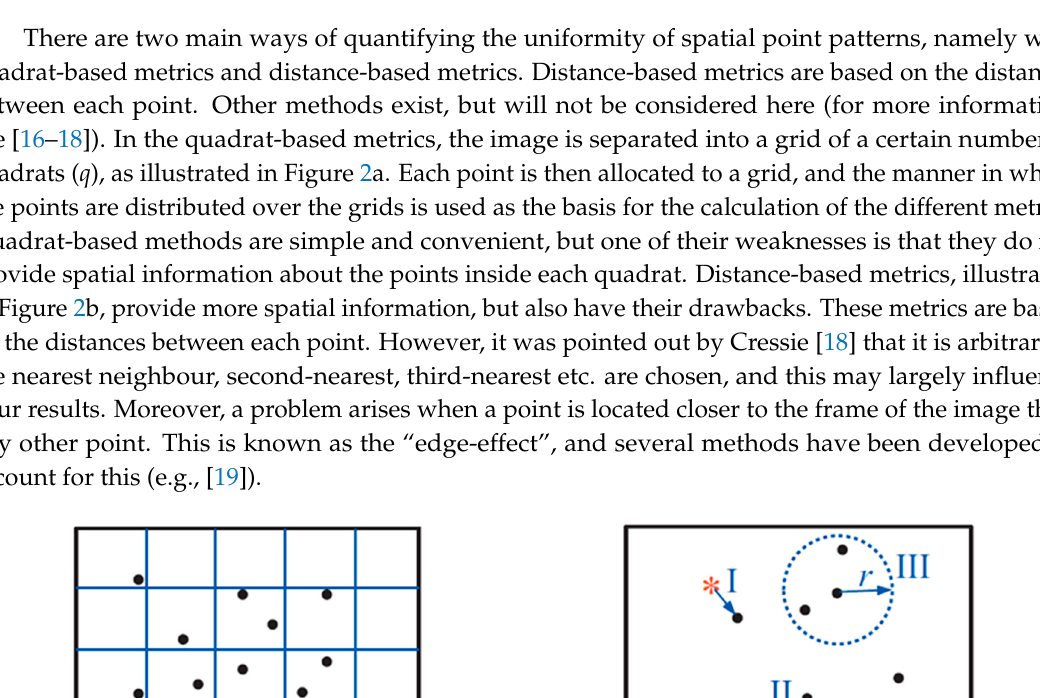
Figure 1. Examples of a complete spatial random (CSR) pattern ( a ) and a non-uniform matern cluster pattern ( b ).